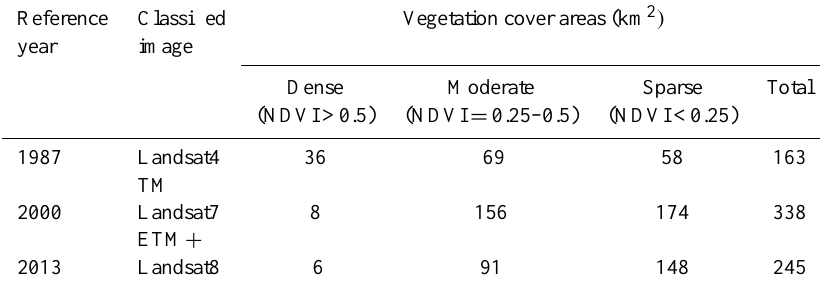
Table 1. Spatiotemporal characteristics of Al-Kharj ecosystem.